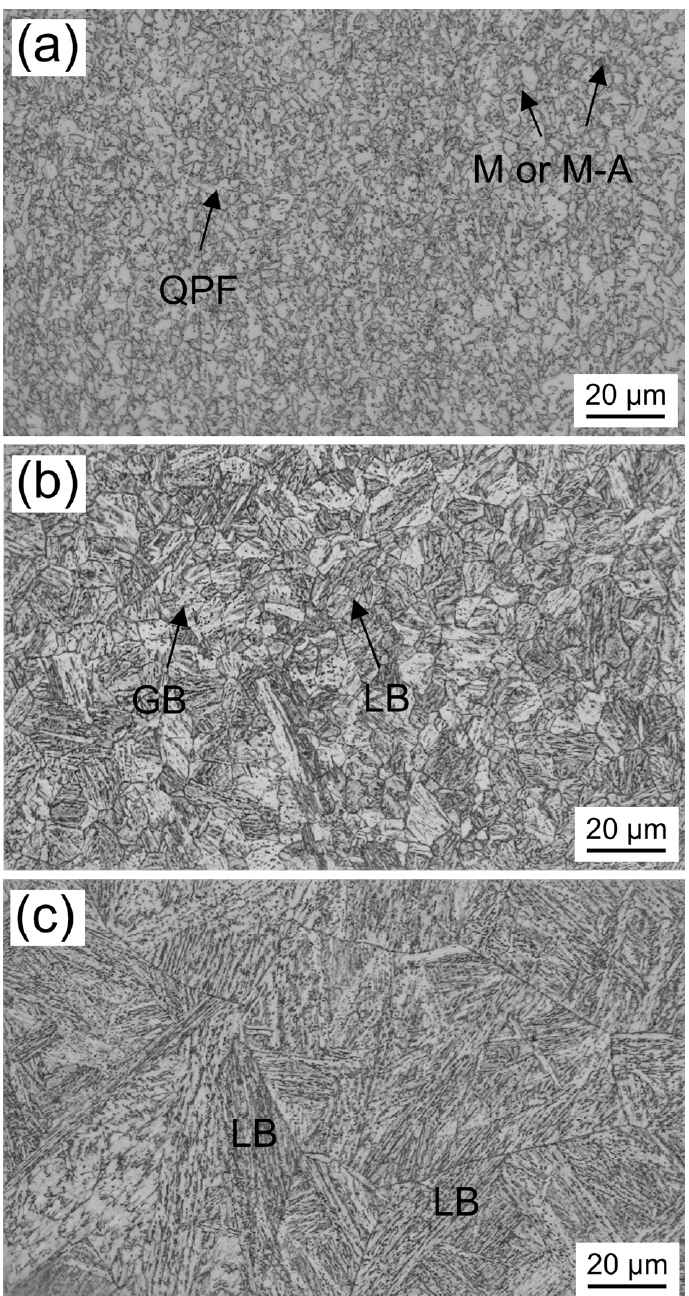
Figure 2. Typical micrographs of the experimental steel with different austenitizing temperatures: ( a ) 860 °C; ( b ) 1000 °C; ( c ) 1250 °C (M: martensite; M-A: martensite-austenite constituent; QPF: quasi- polygonal ferrite; LB: lath bainite; GB: granular bainite;).